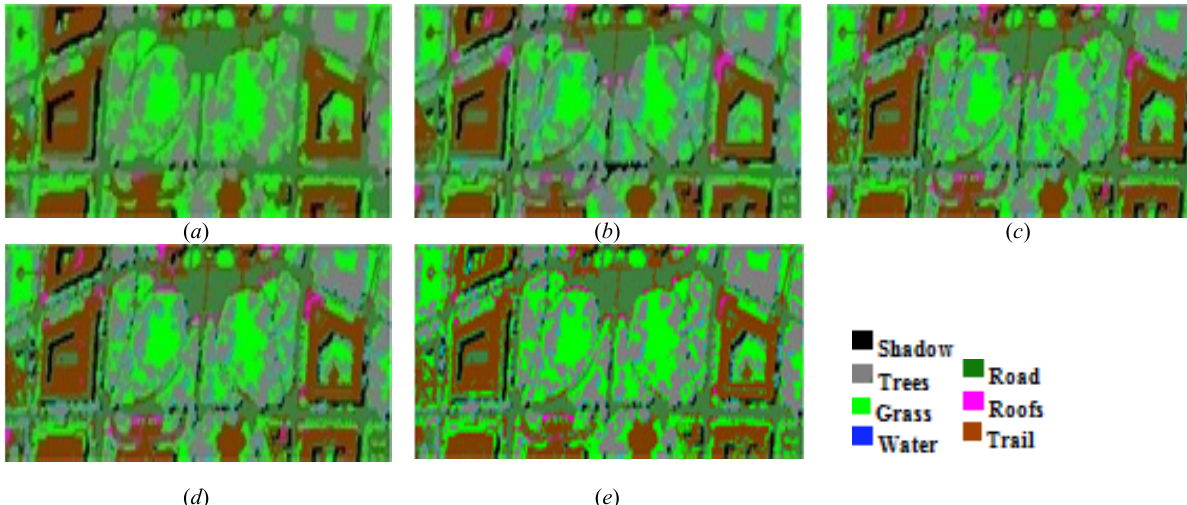
Figure 4. ( a ) MLP Classification map, ( b ) original-MHS classification map, ( c ) enhanced-MHS Classification map, ( d ) proposed Classification map, ( e ) Reference